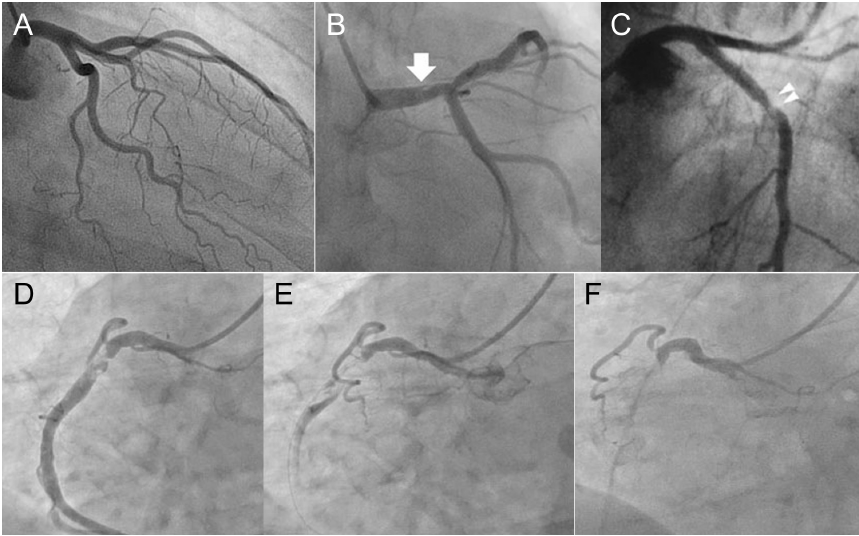
Figure 1. a-f. TIMI thrombus classification. (a) TIMI thrombus grade 0; (b) TIMI thrombus grade 1 (white arrow); (c) TIMI thrombus grade 2 (arrows); (d) TIMI thrombus grade 3; (e) TIMI thrombus grade